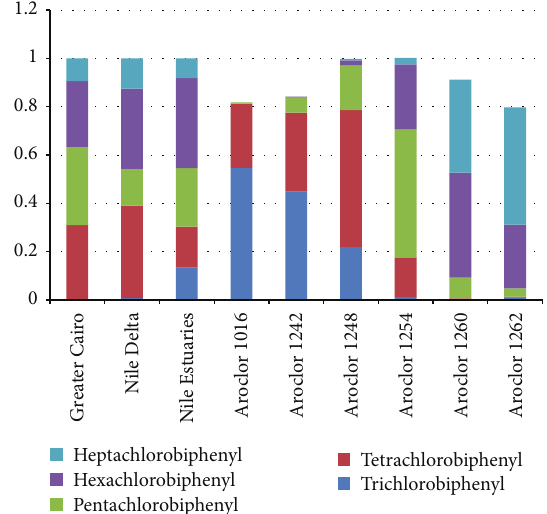
Figure 3: Patterns of PCBs homologues in River Nile water samples, Egypt.